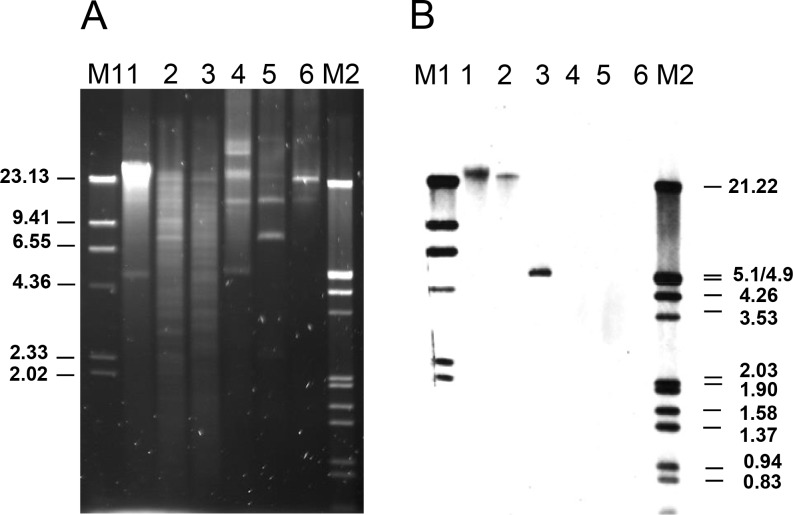
Gel electrophoresis (A) and Southern blot analysis (B) of total genomic and plasmid DNA from L. mesenteroides subsp. mesenteroides LbE16.Order: 1, undigested total DNA; 2, total DNA digested with (lanes 1 and 4, respectively) or digested with PstI, and NsiI (lanes 2, 3 or lanes 5, 6, respectively). As a probe, an internal segment of tet(S) obtained by specific PCR and labelled with digoxigenin was used. M, molecular weight markers: M1, digoxigenin-labelled, HindIII-digested lambda DNA; M2, digoxigenin-labelled, EcoRI and HindIII-digested lambda DNA. The size of the fragments of the molecular weight markers (in kbp) is indicated.